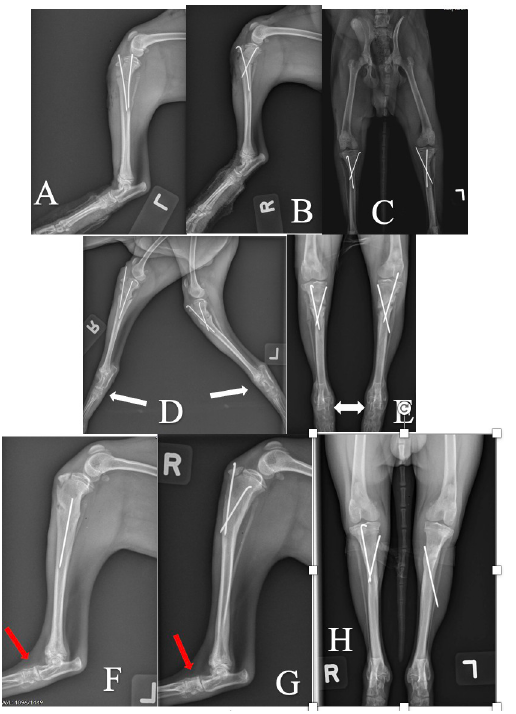
Fig 8. Development of diffuse osteopenia of the tarsus and metatarsus after a bandage was placed for 4 weeks postoperatively (case 37). A, B and C: Bilateral mediolateral and craniocaudal views immediately postoperative. D and E: Mediolateral and craniocaudal views 4 weeks postoperative. There is progressive healing of the proximal tibial fractures. Severe osteopenia is present affecting the tarsal cuboidal bones and proximal metatarsal bones (white arrows). F, G and H: Mediolateral and craniocaudal views 8 weeks postoperative. The proximal tibial fractures have healed appropriately. Mild to moderate osteopenia of distal limbs, but improved compared to radiographs at 4 weeks after surgery (white